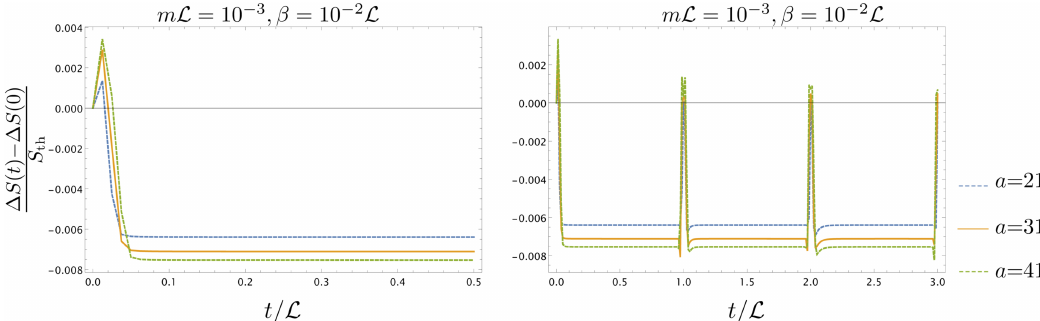
Figure 3 . Time dependence of ∆ S = S OEE − S EE in free massless scalar theory. We take N =1501 , = N + N =20+ a . Left panel corresponds to short-time scales and the right panel N A A L 1( R 1) A L 2( R 2) L ( R ) is for long-time scales.